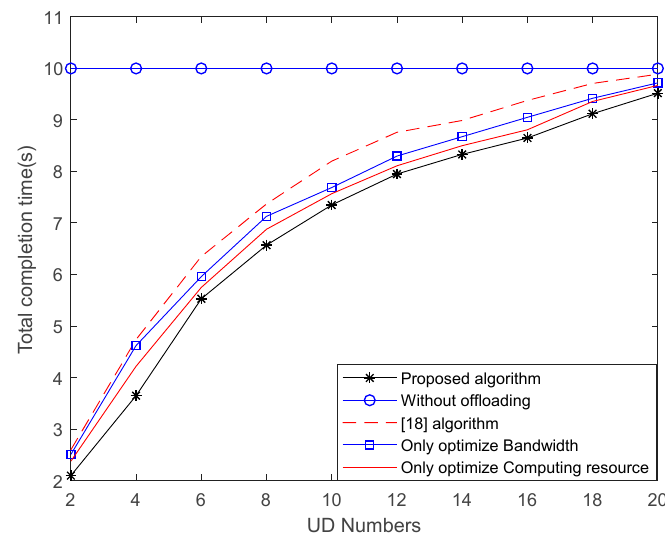
Figure 6. Total completion time with different user device (UD) numbers.